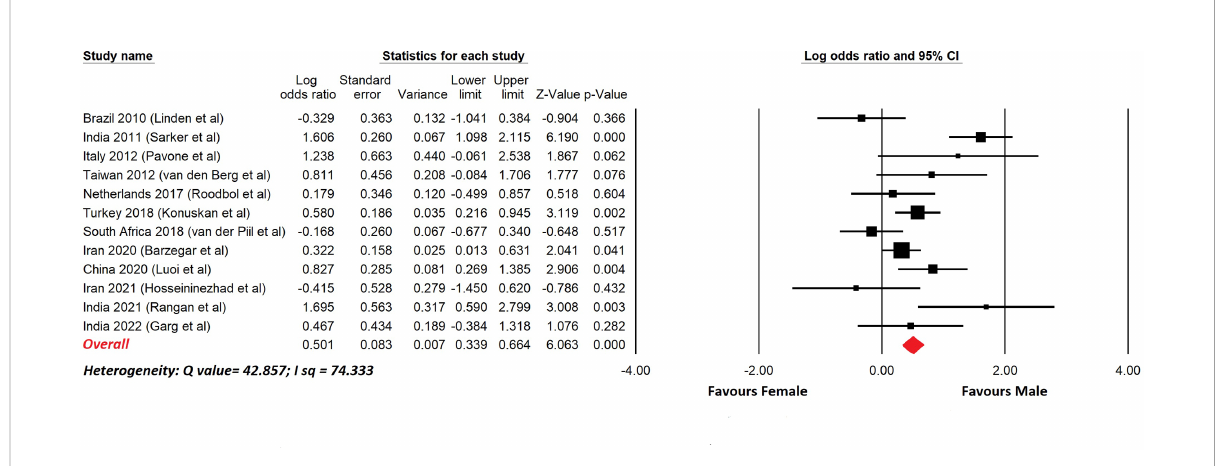
FIGURE 2 Meta-analysis of sex differences in childhood GBS. This shows a meta-analysis of the data from Table 5. Comprehensive Meta-analysis software v 3.31 (Biotech, USA, 2022) was used. Sex differences are displayed using a log odds ratio. The overall odds ratio was 1.6. The overall relative risk was 1.3.